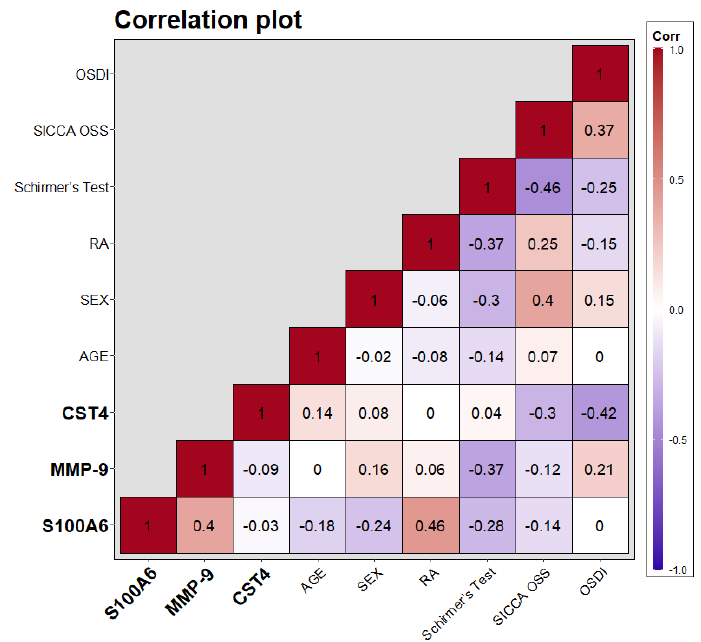
Figure 3. Correlation matrix of the S100A6, MMP-9 and CST4 biomarkers (in bold) in the tear samples and the clinical variables of all the individuals. The r value for each correlation is shown in the squares, and the color scale indicates the degree of significance and its direction (negative in blue, positive in red).